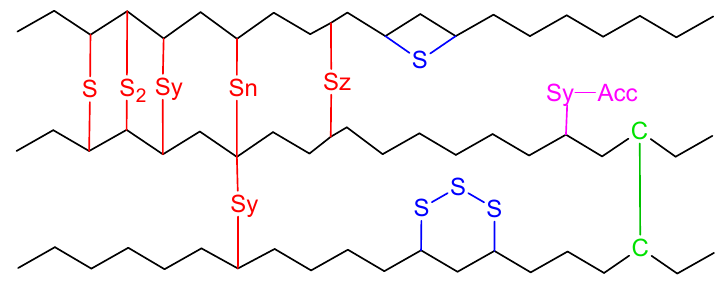
Figure 4. Structures formed as a result of intermolecular curing [37]. Adapted with permission from Ref. [37]. Copyright (2022) American Chemical Society.